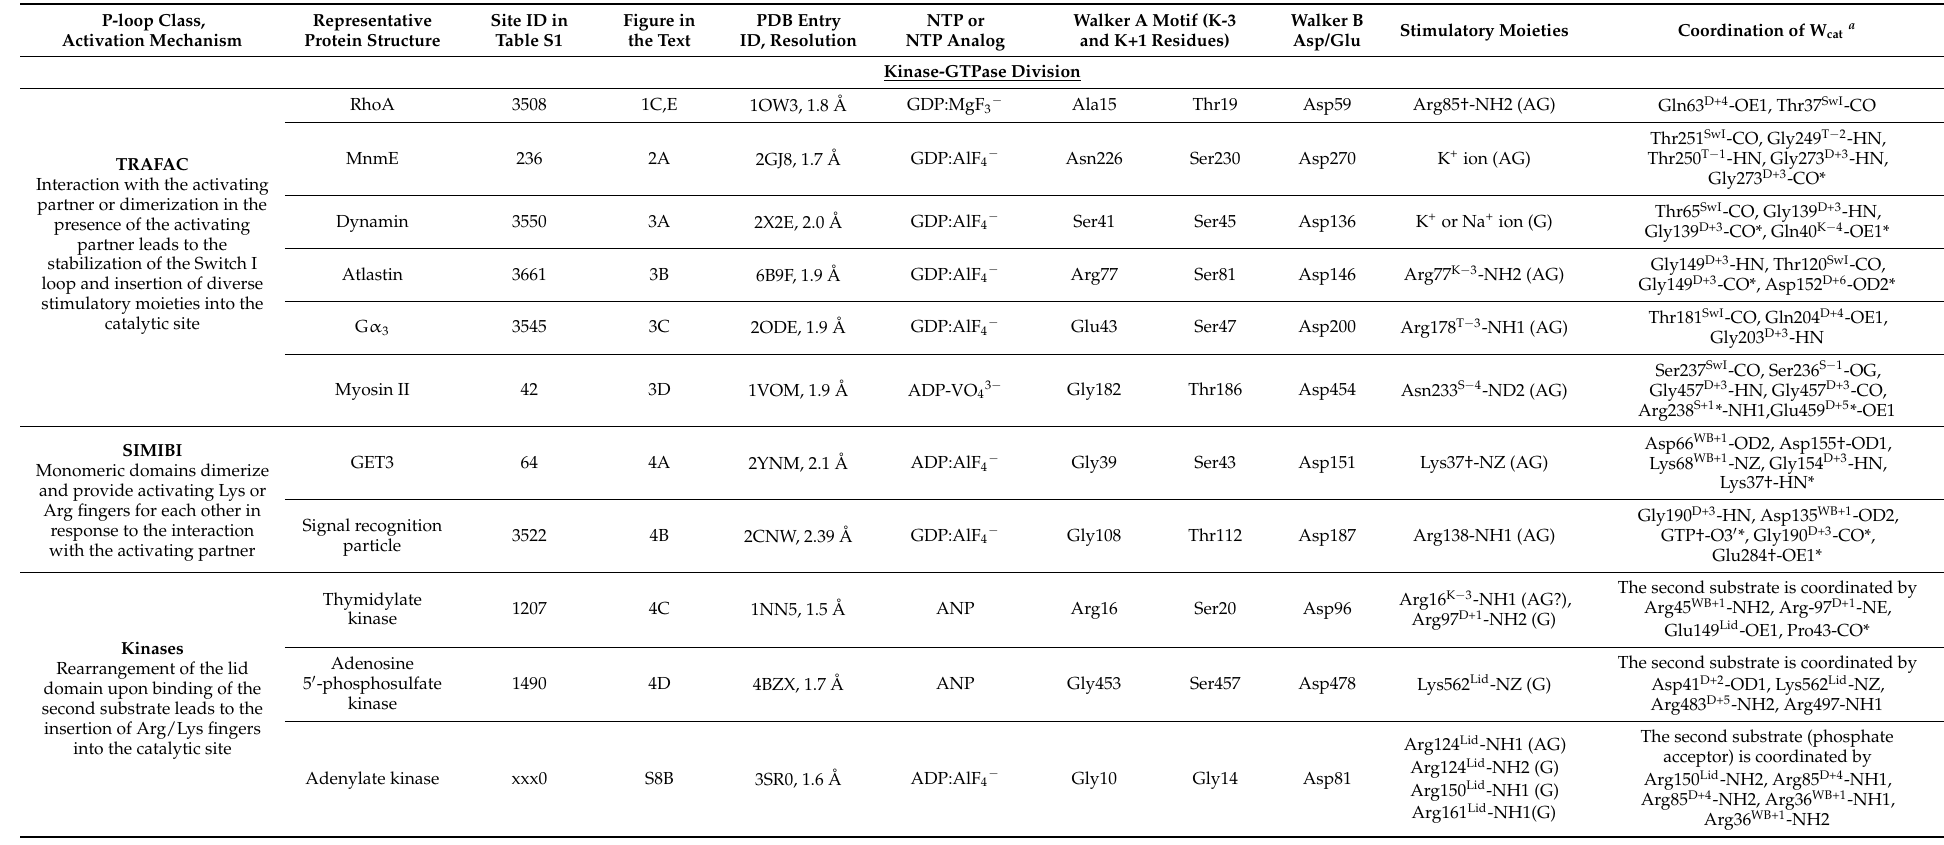
Table 1. Structural traits of representative P-loop NTPases of different